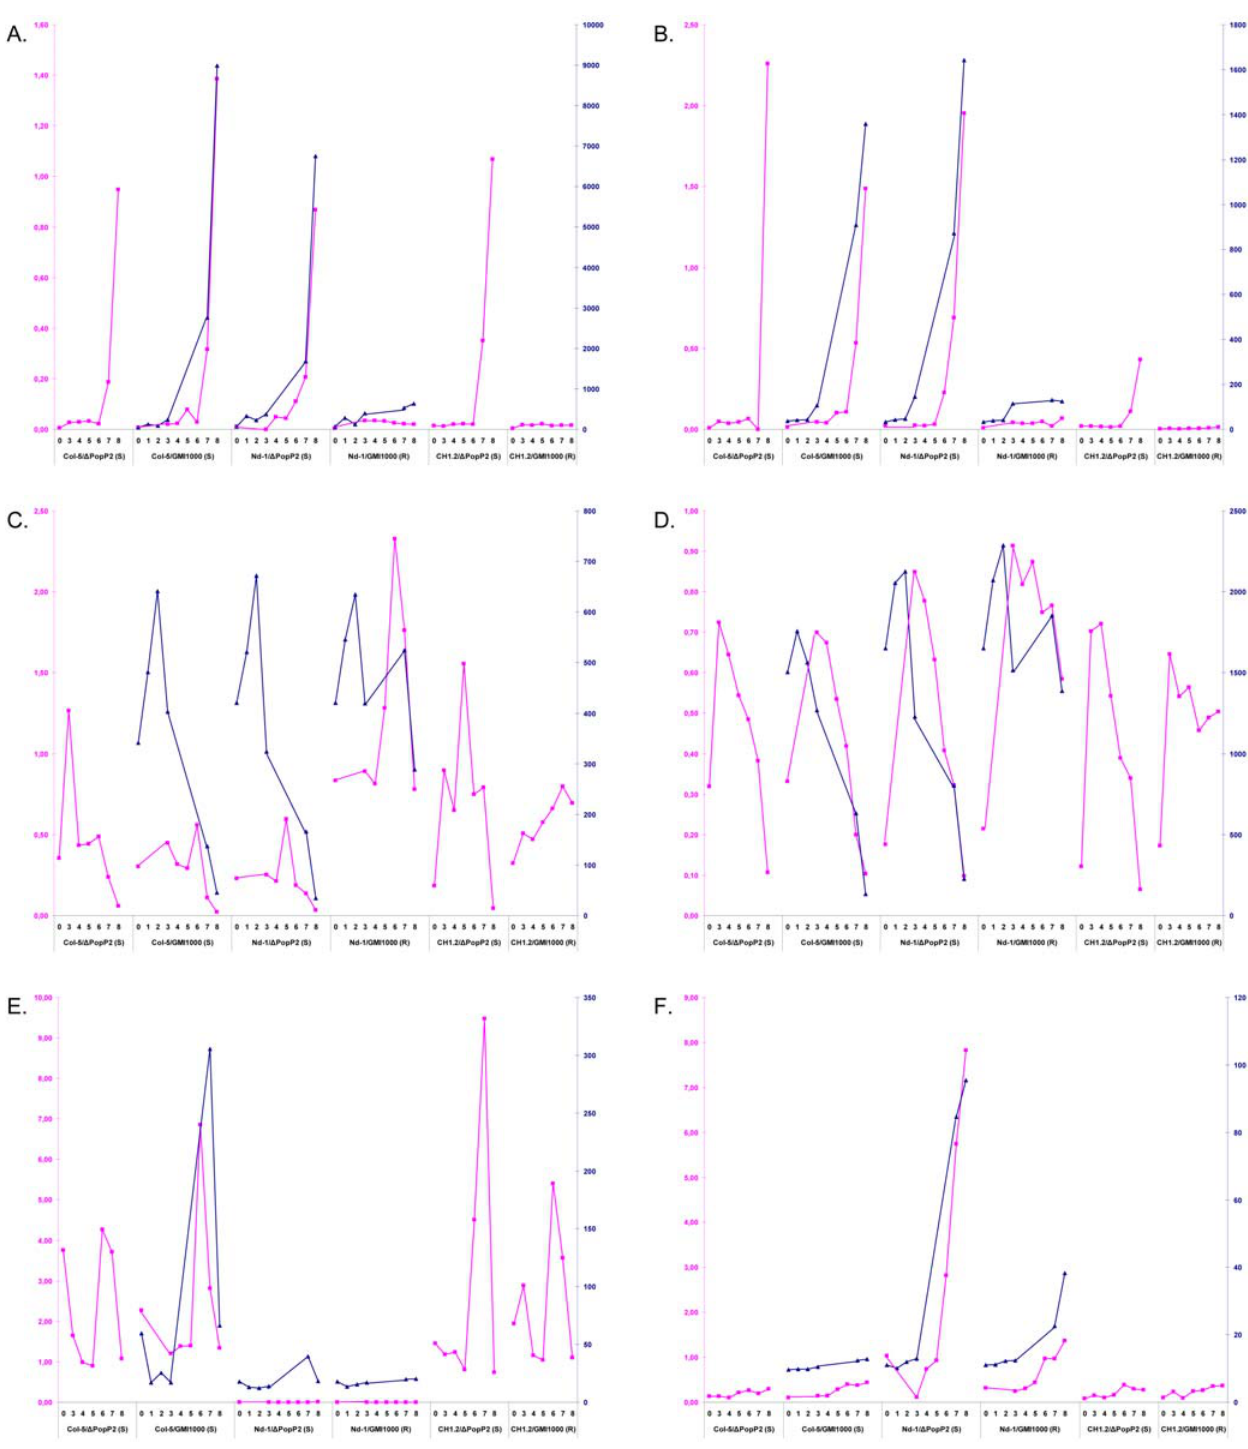
Figure 4. Quantitative RT-PCR validation of microarray results. The microarray data (blue lines) were validated by Q-RT-PCR (pink lines). The outcome of each interaction is indicated below each panel (R, Resistance; S, Susceptible).Samples were collected at the times indicated under each panel [0: 0H; 1: 6H; 2: 12H; 3: 24H; 4: 48H; 5: 72H; 6: 96H; 7: 120H (D1); 8: 168H (D3)] from: Nd-1 plants inoculated either with GMI1000 (R) or GMI1000 D PopP2 (S); Col-5 plants inoculated with GMI1000 (S) or GMI1000 D PopP2 (S); transgenic CH1.2 plants inoculated either with GMI1000 (R) or GMI1000 D PopP2 (S). The blue scale is for normalized Affymetrix data set and the pink one is for the relative quantity of RNA by Q-RT-PCR. Each panel describes the results obtained with different genes. A. and B. Dehydrin – Rab18 (At5g66400) and a putative Protein Phosphatase 2C (At5g59220) respectively, two genes up-regulated in diseased Nd-1 and Col-5 plants. C. and D. Basic helix-loop-helix family protein (At4g36540) and an expressed protein (At5g25460) respectively, two genes down-regulated in diseased Nd-1 and Col-5 plants. E. Ethylene-responsive element-binding protein (At4g17490), specifically up-regulated in diseased Col-5 plants. F. NADP-dependant oxydoreductase, putative (At5g16980), specifically up-regulated in diseased Nd-1 genes.